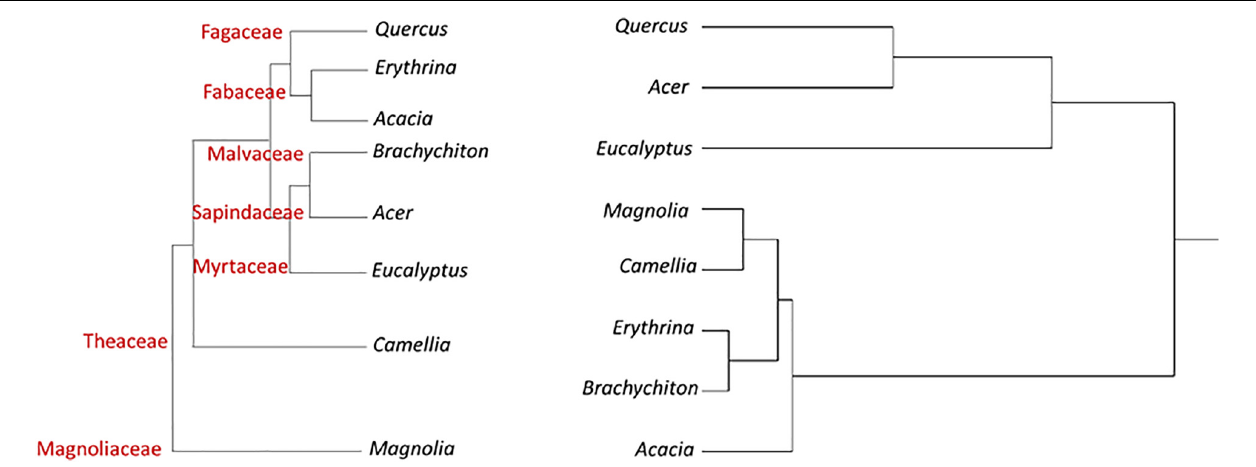
FIGURE 2 | Hierarchical clustering dendrogram of eight botanical genera based on three susceptibility categories of tree species to PSHB (right, based on Table 6 ); as compared with phylogenetic tree of these genera [left, according to Soltis et al. (2011)].